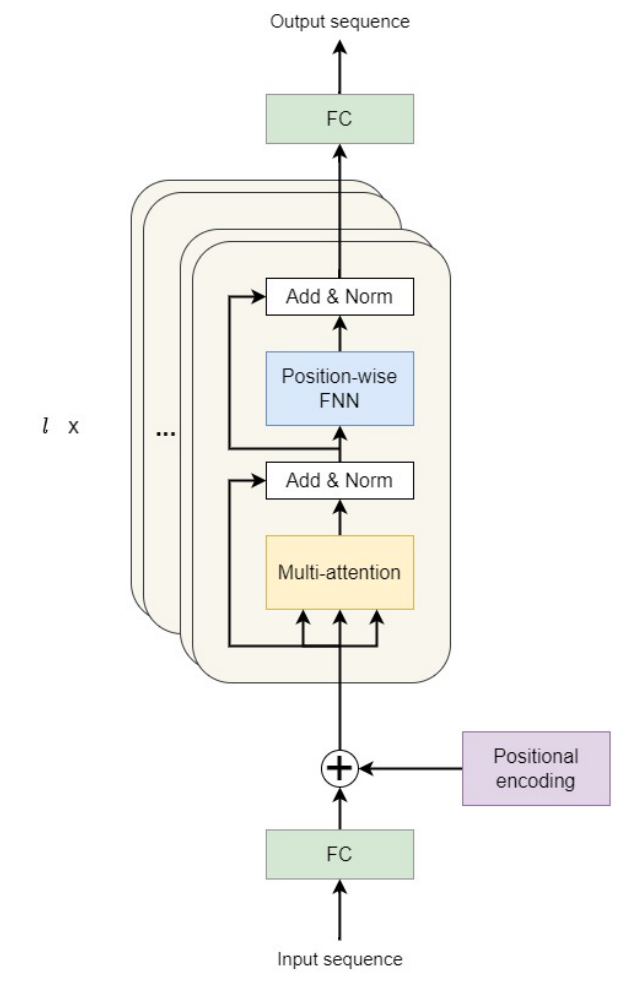
Figure 5. The architecture of the Transformer